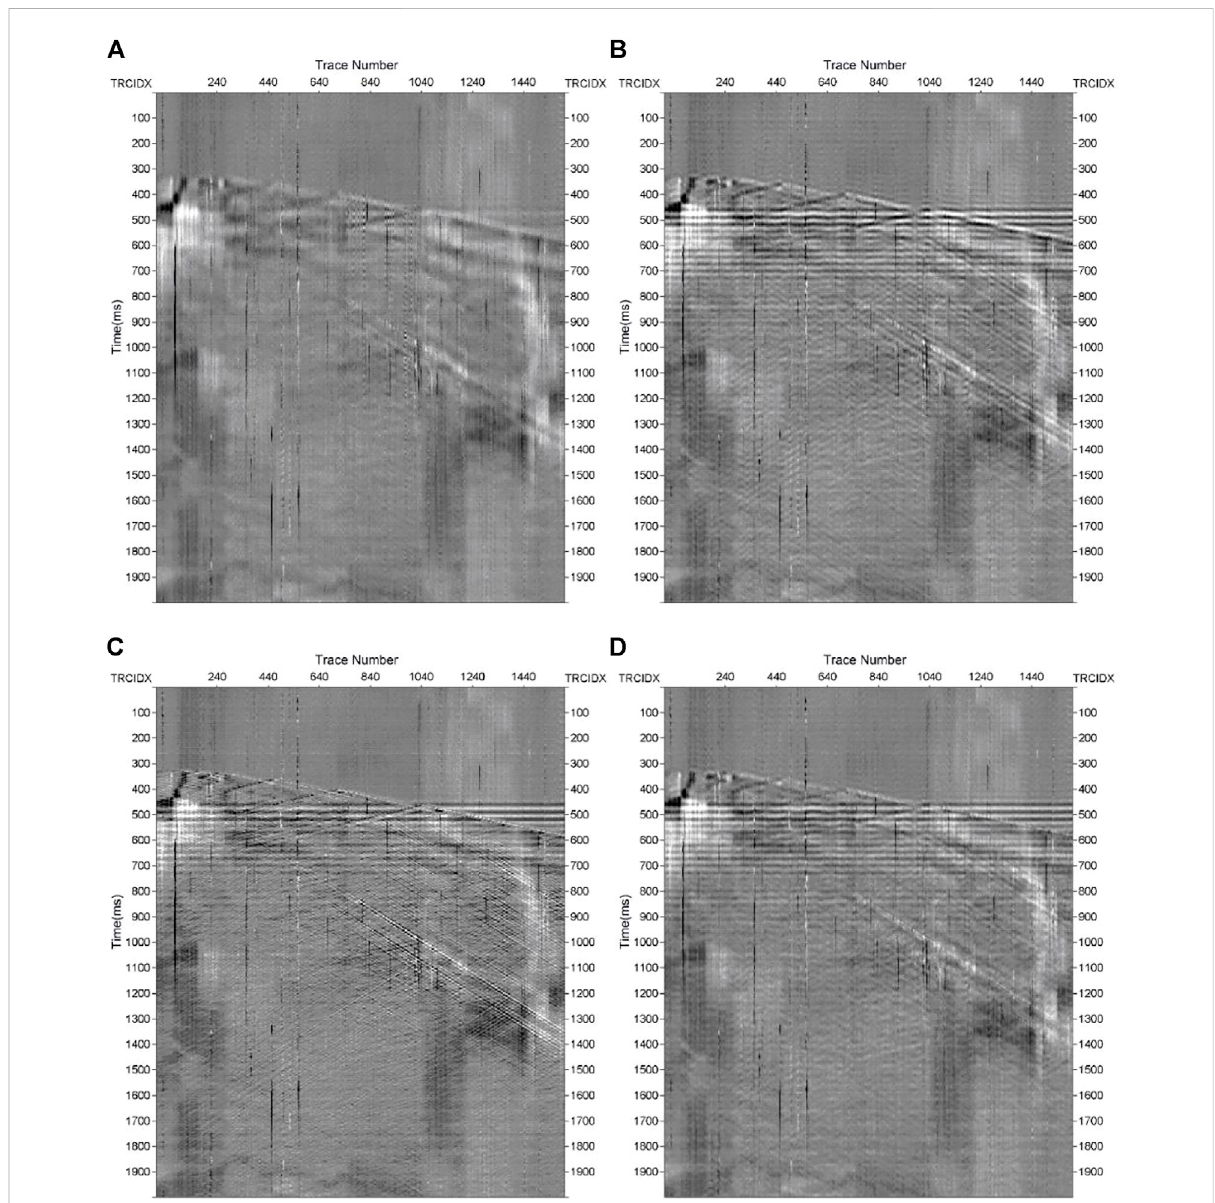
FIGURE 13 Difference mapsfromdenoisedresults inFigure12. (A) Difference mapfromrealDASrecordanddenoised resultfromVMD, (B) difference map from real DAS record and denoised result from band-pass fi ltering, (C) difference map from real DAS record and denoised result from DnCNNs, (D) difference map from real DAS record and denoised result from